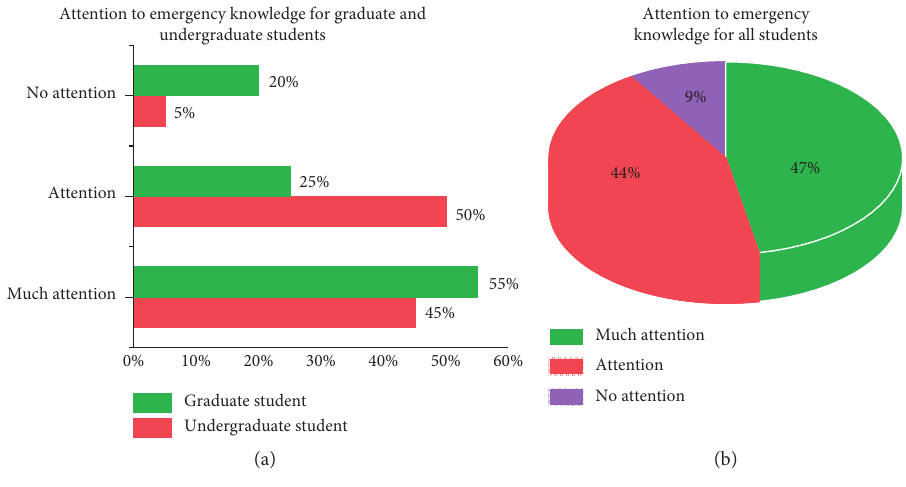
Figure 3: Attention to emergency knowledge.